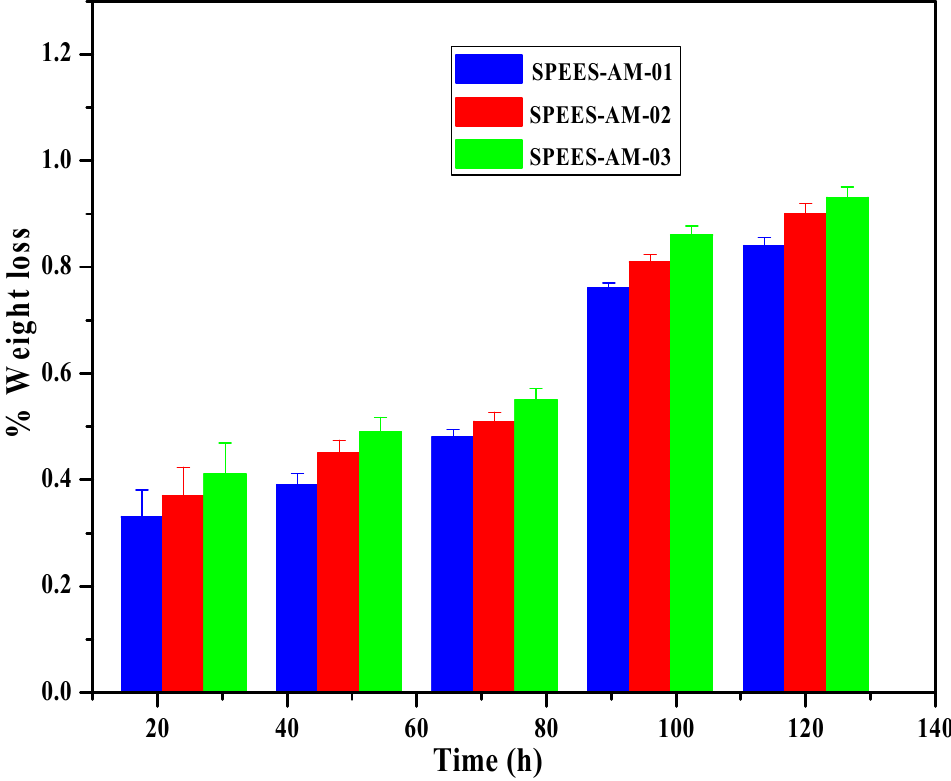
Figure 8. Oxidative stability test for SPEES-AM-based membranes at 60 °C.